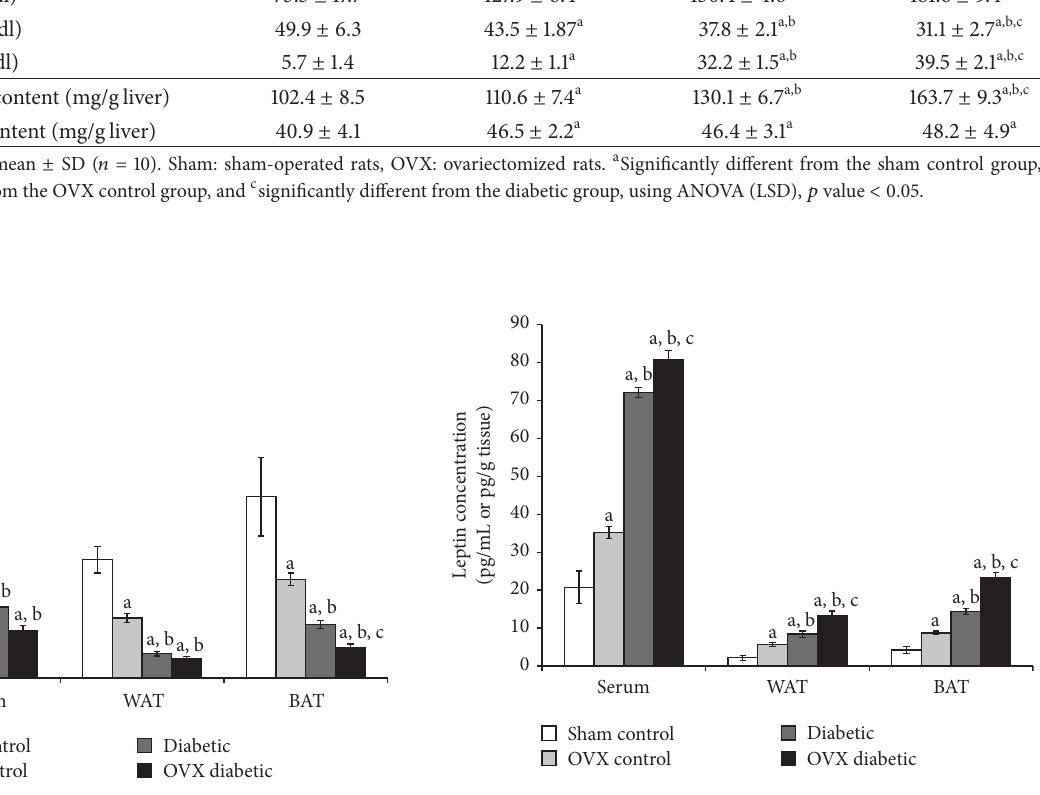
Figure 3: Leptin level in serum (pg/mL) and adipose tissues (pg/g tissue) of different studied groups at the end of the